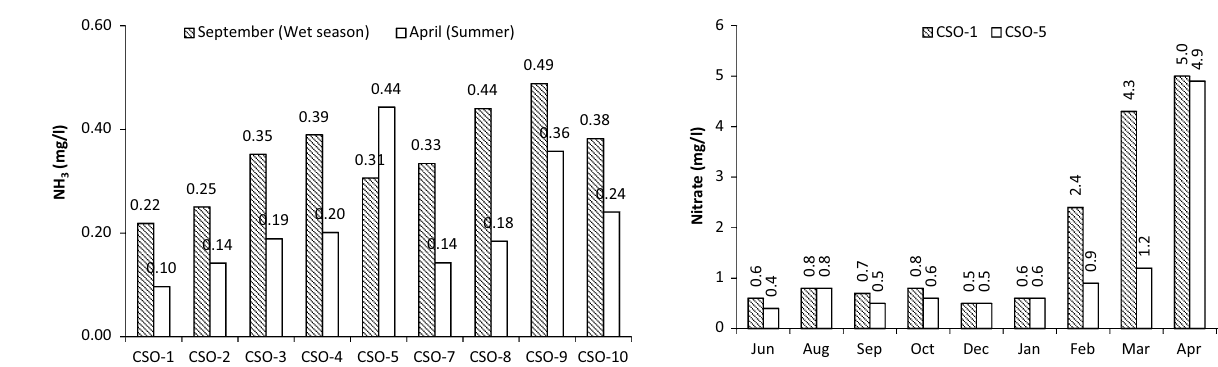
Fig. 7 Calculated free ammonia concentration (as NH the 9 sampling locations close to the CSO structures in September (Wet season) and April (Summer)